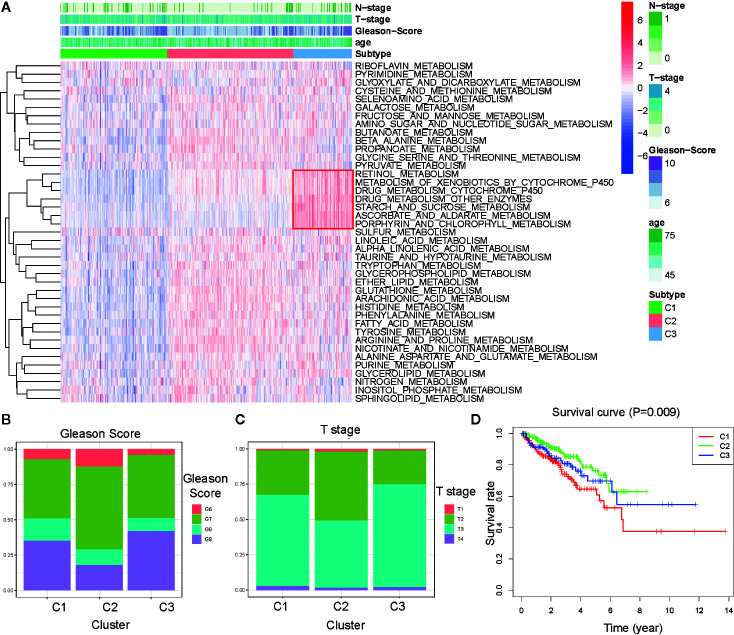
Association between clinical characteristics and the metabolism-associated subtypes. (A) Heatmap of the ssGSEA score calculated by metabolic pathways gene sets and specific metabolic pathways of C3 in the red frame. Gleason score (B) and Primary Tumor (T) stage (C) for each metabolism-associated subtype in the TCGA cohort. The P values are labeled above each boxplot with asterisks (ns represents no significance, *P < 0.05, **P < 0.01, ***P < 0.001). (D) Survival curves for each metabolism-associated subtype in the TCGA cohort. The horizontal axis represents survival time (year), and the vertical axis represents the probability of survival. The log-rank test was used to assess the statistical significance of the differences between the three subtypes.